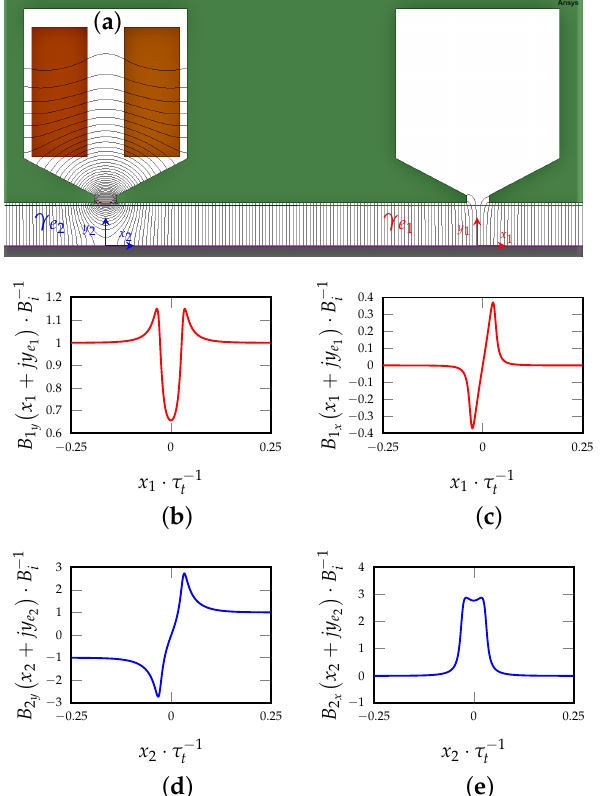
Figure 8. ( a ) Flux lines in front of the energized and not energized slot (slot opening b so = 6 mm); ( b ) normal and ( c ) tangential p.u. FEM components on γ e ( d ) normal and ( e ) tangential p.u. FEM components on γ e